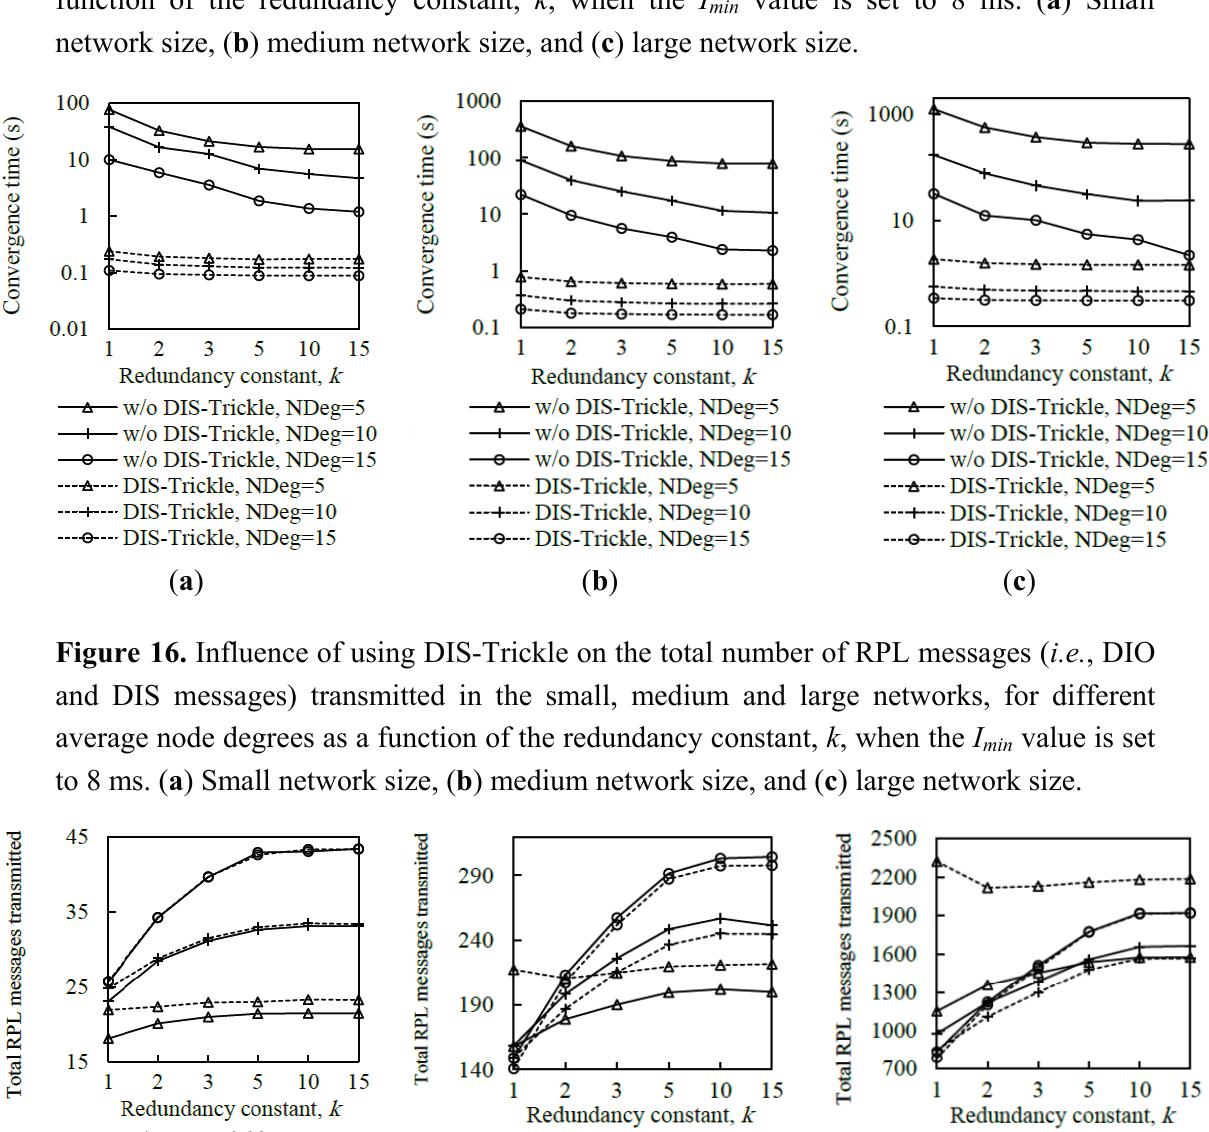
Figure 15. Influence of using DIS-Trickle on network convergence time in the small, medium and large network scenarios, for different average node degrees, NDeg, as a function of the redundancy constant, k , when the I value is set to 8 ms. ( a ) Small min network size, ( b ) medium network size, and ( c ) large network size.